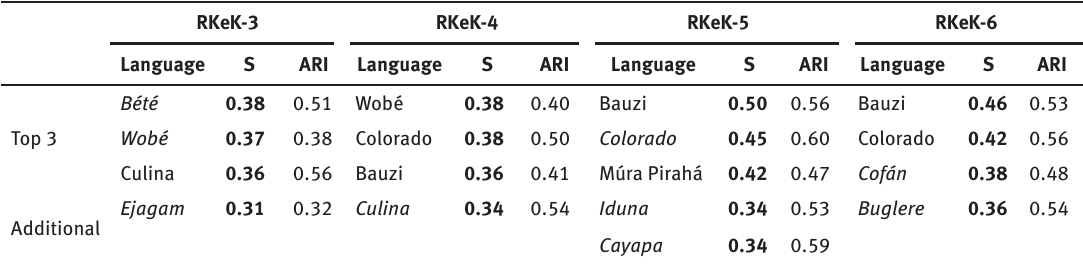
Table 4: Similarities between RKeK results and some languages in the WCS.